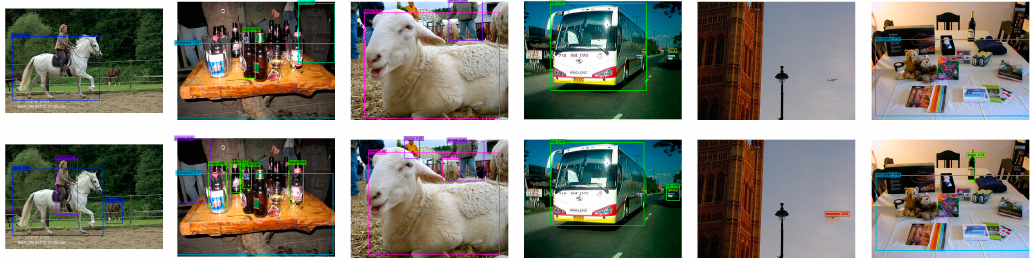
( a ) The detection results of small object detection. Figure 8.